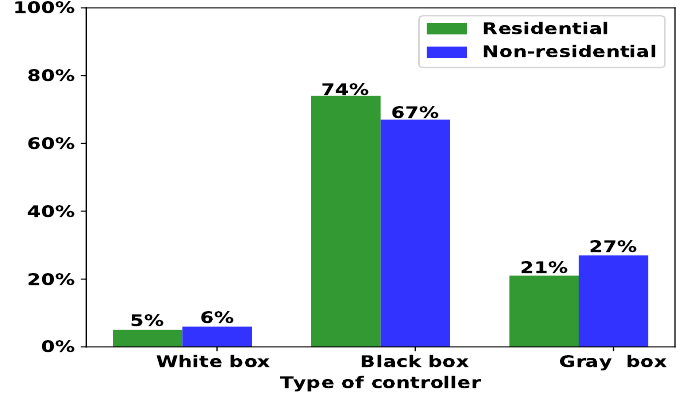
Figure 8. Research conducted on type of building.